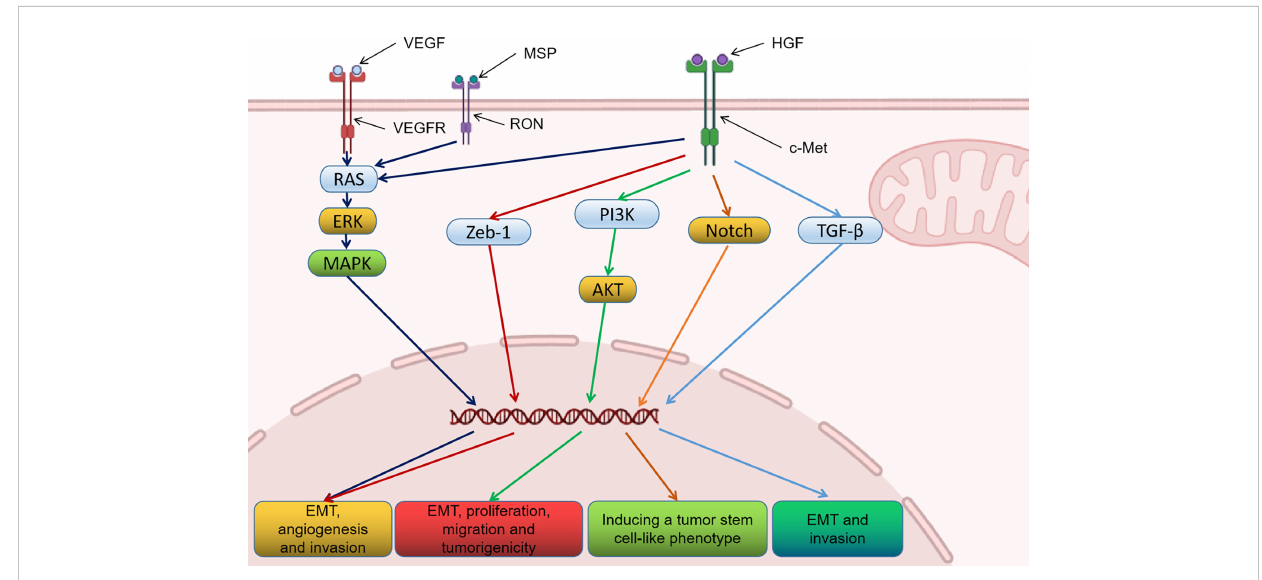
FIGURE 1 The role of c-Met signaling pathway in urinary tumor progression.